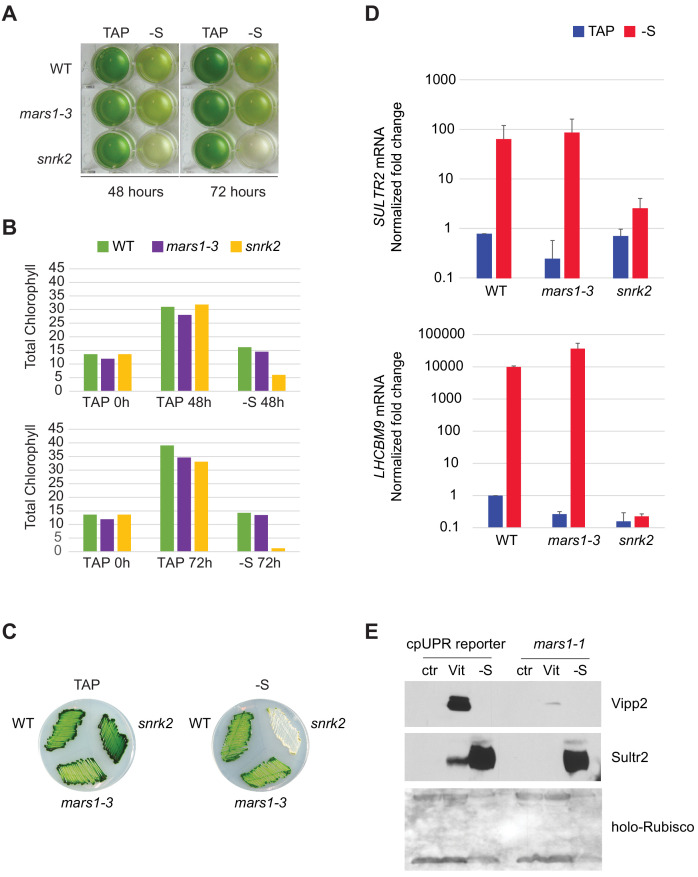
mars1 cells activate sulfur starvation genes and survive in sulfur-limiting conditions.(A) WT, mars1-3 and snrk2 cells grown till saturation were harvested, washed twice in sulfur-depleted TAP (-S) and resuspended in TAP or sulfur-depleted TAP to a final chlorophyll concentration of ~13 µg/ml. Cultures were sampled at 48 and 72 hr to take photographs and measure total chlorophyll concentration. snrk2 cells were used as a positive control given the essential role of the Snrk2/Stpk12 kinase in the activation of the sulfur starvation response (González-Ballester et al., 2010; Gonzalez-Ballester et al., 2008). (B) Histograms of total chlorophyll concentrations (µg/ml) measured from TAP liquid cultures collected during the experiment described in Figure 5—figure supplement 4A. (C) WT, mars1-3 and snrk2 cells were streaked on TAP or sulfur-depleted TAP (-S) agar plates. Photographs were taken after 12 days of growth in normal light. (D) The same strains described in Figure 5—figure supplement 4A were subjected to quantitative PCR analysis and the level of expression of SULTR2 and LHCBM9 transcripts, encoding two sulfur starvation-responsive proteins (González-Ballester et al., 2010; Pootakham et al., 2010), was measured after 24 hours of growth in TAP or sulfur-depleted TAP (-S). GBLP was chosen as reference gene during normalization. (E) Immunoblot analysis of samples prepared from the cpUPR reporter and mars1 cells grown in ClpP1-permissive (ctr) and ClpP1-nonpermissive (Vit) conditions or subjected to sulfur starvation (-S) for 2 days using antibodies against Vipp2, SultR2 and holo-Rubisco (as loading control).